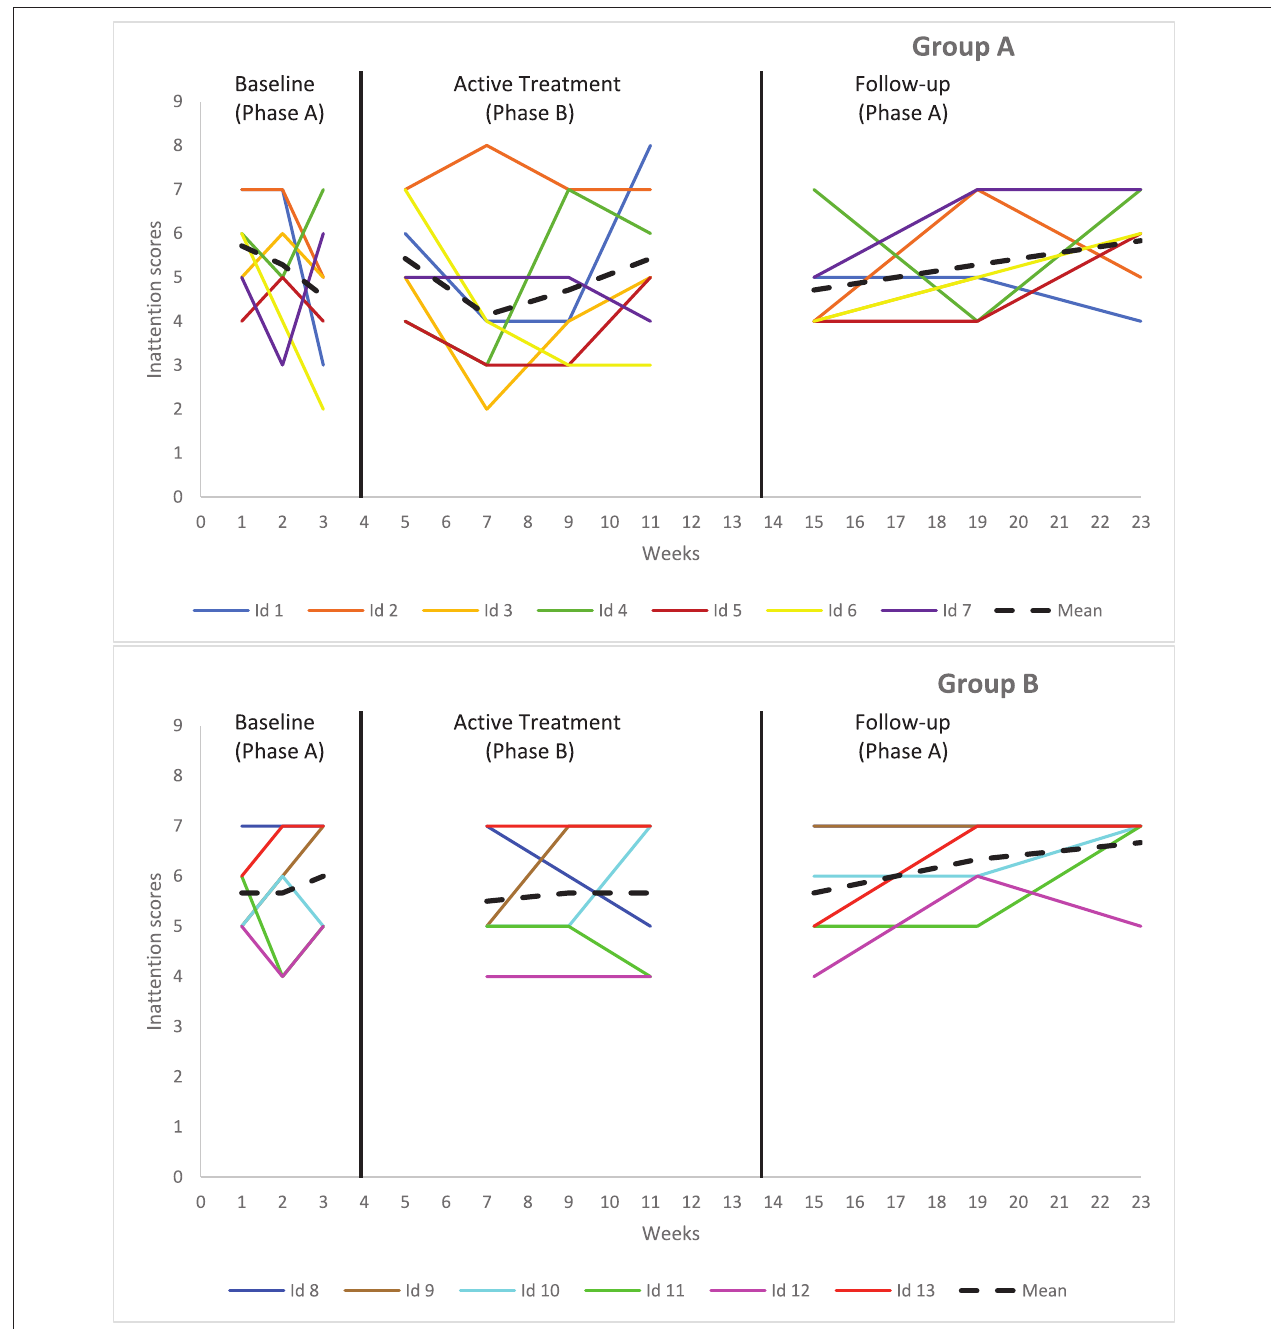
FIGURE 7 | Graphical display of baseline level and changes in level between consecutive phases in inattention for teacher-reported